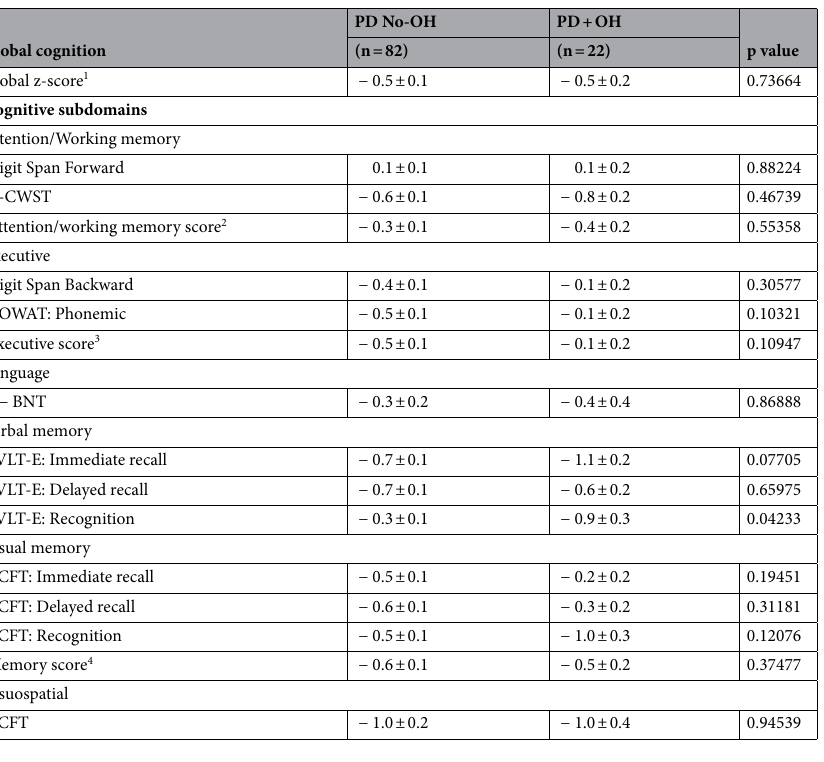
Table 4. Between-group differences of global cognition and its subdomains. Scores of neuropsychological assessments are presented as means ± standard error (SE). Between-group disparities of cognitive tests were investigated by analysis of covariance (ANCOVA), adjusted for age, disease duration, and education years. Statistical significance was defined as a two-tailed p-value < 0.05. K-CWST, Korean-Color Word Stroop Test; COWAT, Controlled Oral Word Association Test; K-BNT, Korean-Boston Naming Test; SVLT-E, Seoul Verbal Learning Test-Elderly’s version; RCFT, Rey Complex Figure Test. 1 Average z-scores of attention/working memory score, executive score, K-BNT, memory score, and RCFT. 2 Average z-scores of Digit Span Forward, K-CWST. 3 Average z-scores of Digit Span Backward, COWAT: Phonemic. 4 Average z-scores of